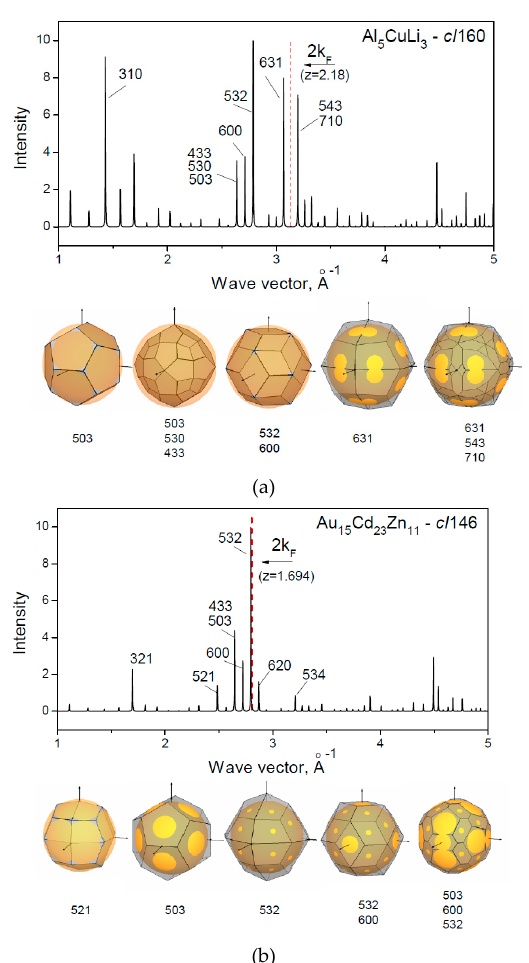
Figure 3. Calculated diffraction patterns for quasicrystal approximants (upper panel) and corresponding Brillouin-Jones zones with the Fermi spheres (lower panel). The position of 2 k F for a given valence electron number per atom z and the hkl indices of the planes used for the BZ construction are indicated on the diffraction patterns. ( a ) Al 5 CuLi 3 - cI 160; and ( b ) Au 15 Cd 23 Zn 11 - cI 146. Structural data and FS–BZ evaluation data are given in Table 1.